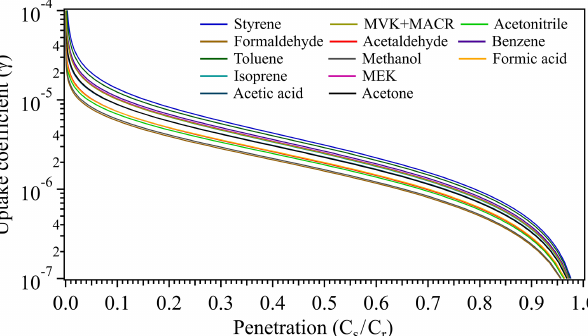
Figure 2. Schematic of the uptake coefficients versus the penetra- tions of measured VOC species. Derivation of the uptake coeffi- cients are based on the experimental parameters: volumetric flow rate F = 0 . 1Lmin − 1 at 1atm and 298K; coated-wall flow tube di- mension, d = 1 . 6cm, L =